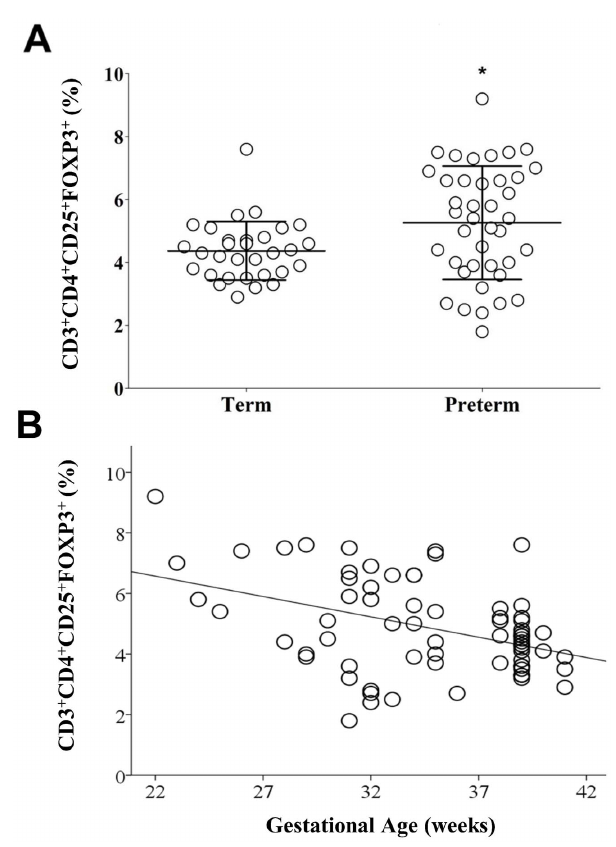
Figure 2. Increased percentage of Tregs in CB of preterm infants and correlates with gestational age. ( A ) Vertical scatter plot comparing mean percentage of Tregs (CD3 + CD4 + CD25 + FOXP3 + ) in CB of term (n=31) and preterm (n=40) infants. Statistical significance was determined by independent sample T-test (*p=0.015) ( B ) Scatter plot graph showing a negative correlation between gestational age (X-axis, in weeks) and CB Tregs percentage (Y-axis). Pearson’s correlation test used (r= 2 0.414,